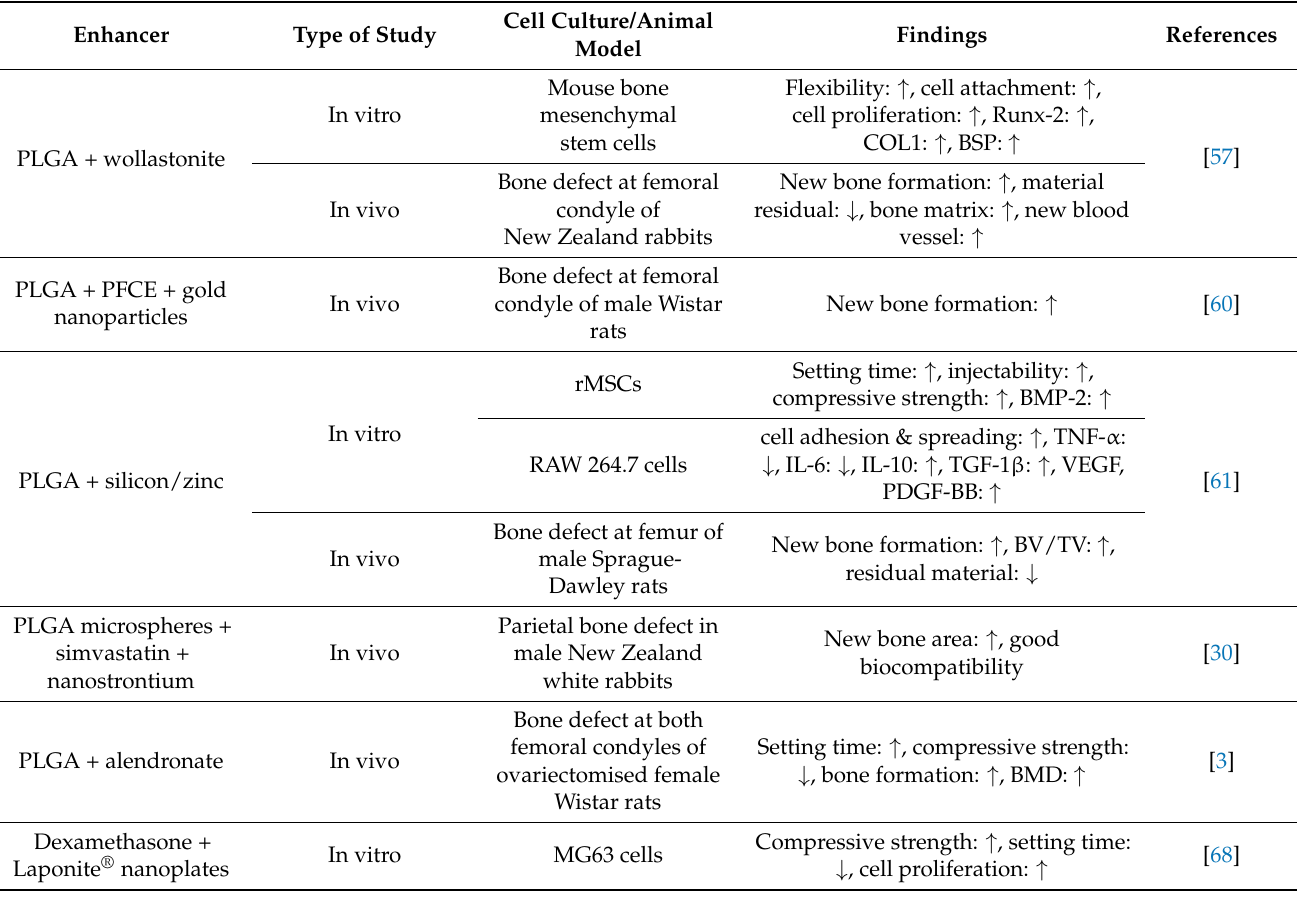
Table 4. Bone-sparing properties of CPC enhanced by the combination of two or more synthetic materials. Enhancer Type of